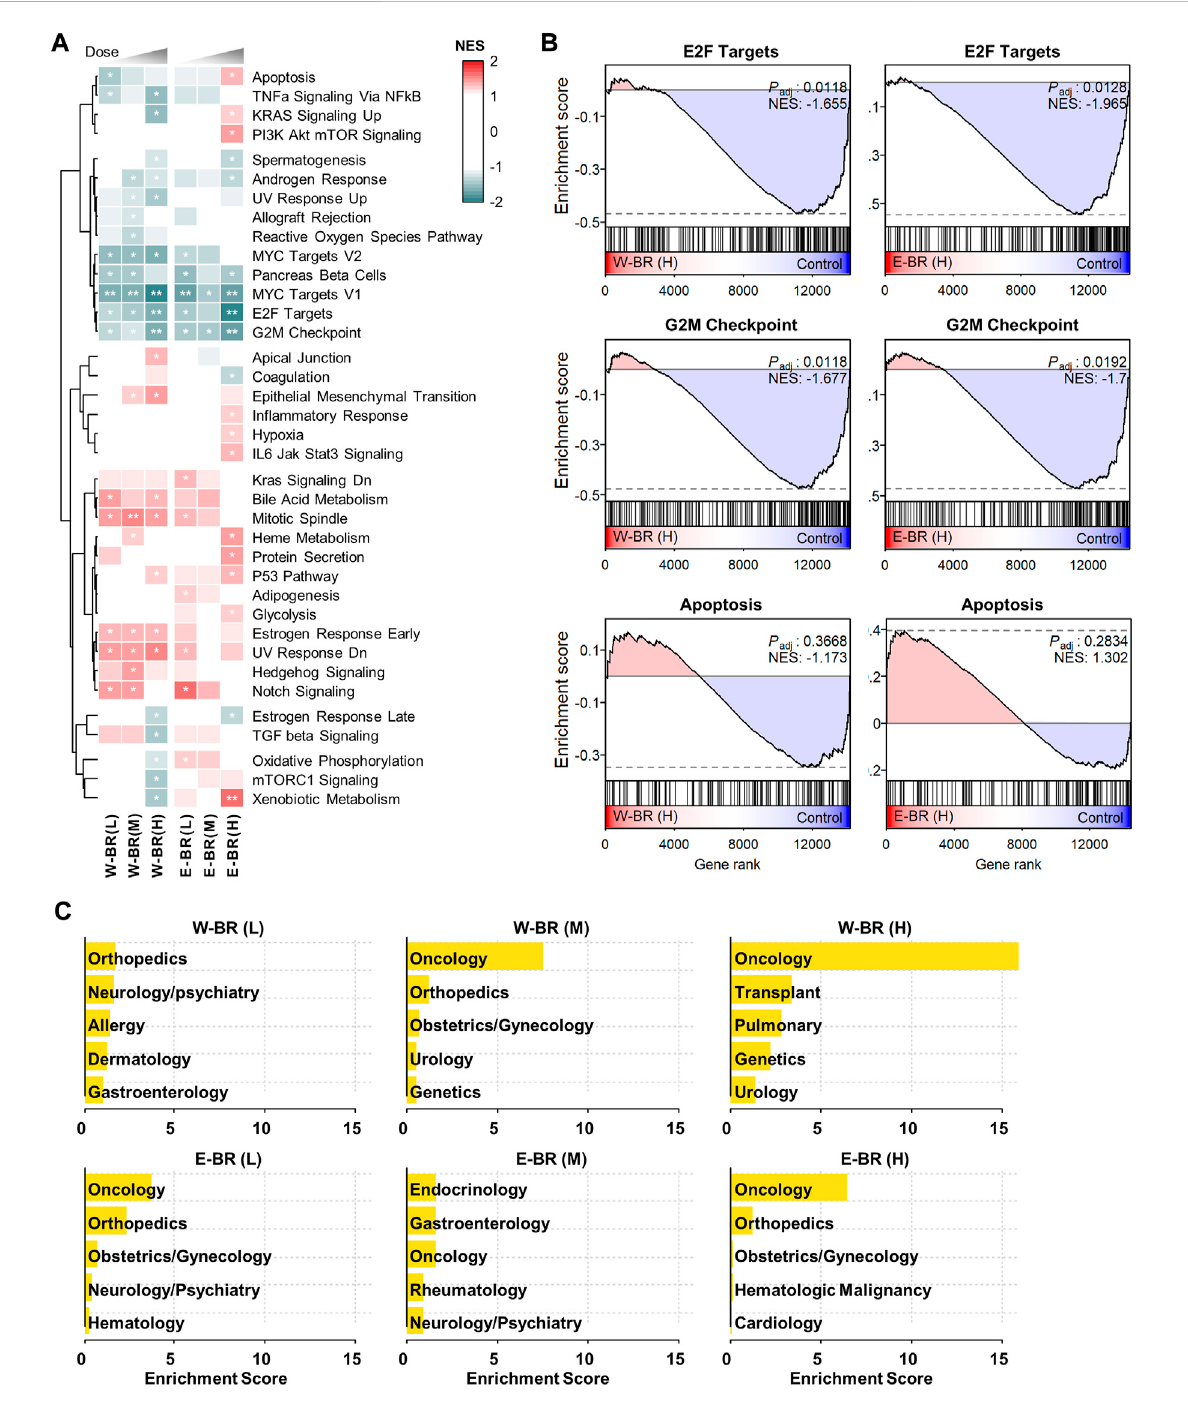
FIGURE 1 Transcriptomic signatures of bupleuri radix water extract (W-BR) and bupleuri radix ethanol extract (E-BR). (A) Dose-dependent gene set enrichment analysis results of W-BR and E-BR with the 50 hallmark gene sets. Only 37 gene sets with at least one condition showing a change of adjusted p -value( P adj ) < 0.3weredisplayed.* P adj < 0.3and** P adj < 0.05vs.DMSOvehiclecontrol. (B) Theselectionsrelatedtoanti-cancereffectsof W-BR (left) and E-BR (right). (C) The top-enriched indications of drugs whose expression signatures were similar to those of W-BR (upper) and E-BR (lower). A total of 384 FDA-approved drugs in the Connectivity Map database were used for comparison. The enrichment score is de fi ned as – log 10 ( p -value) estimated in the hypergeometric test. L, M, and H denote the conditions of low, medium, and high dose, respectively. E-BR: Bupleuri radix ethanol extract; W-BR: Bupleuri radix water